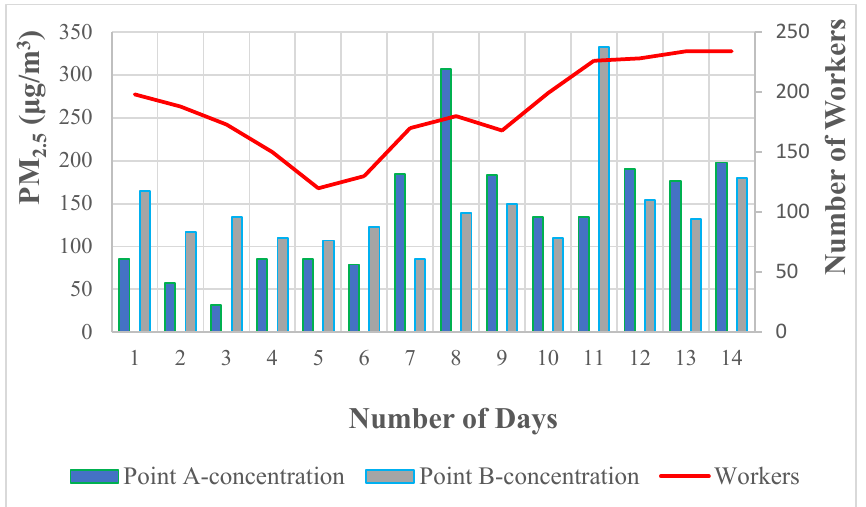
Figure 4. The levels of PM 2.5 concentration and the number of workers at a construction area throughout a 14-day monitoring campaign in a large shopping mall. Table 1. Descriptive statistics for PM 2.5 concentration at the construction site (in µ g/m 3